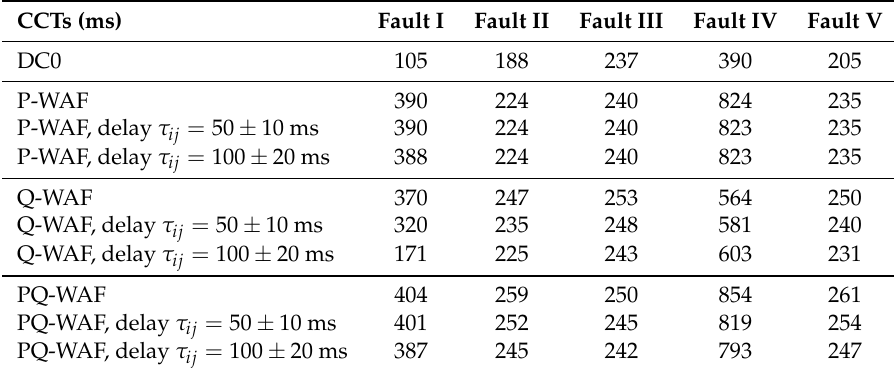
Table 14. Case D. CCT. Effect of communication